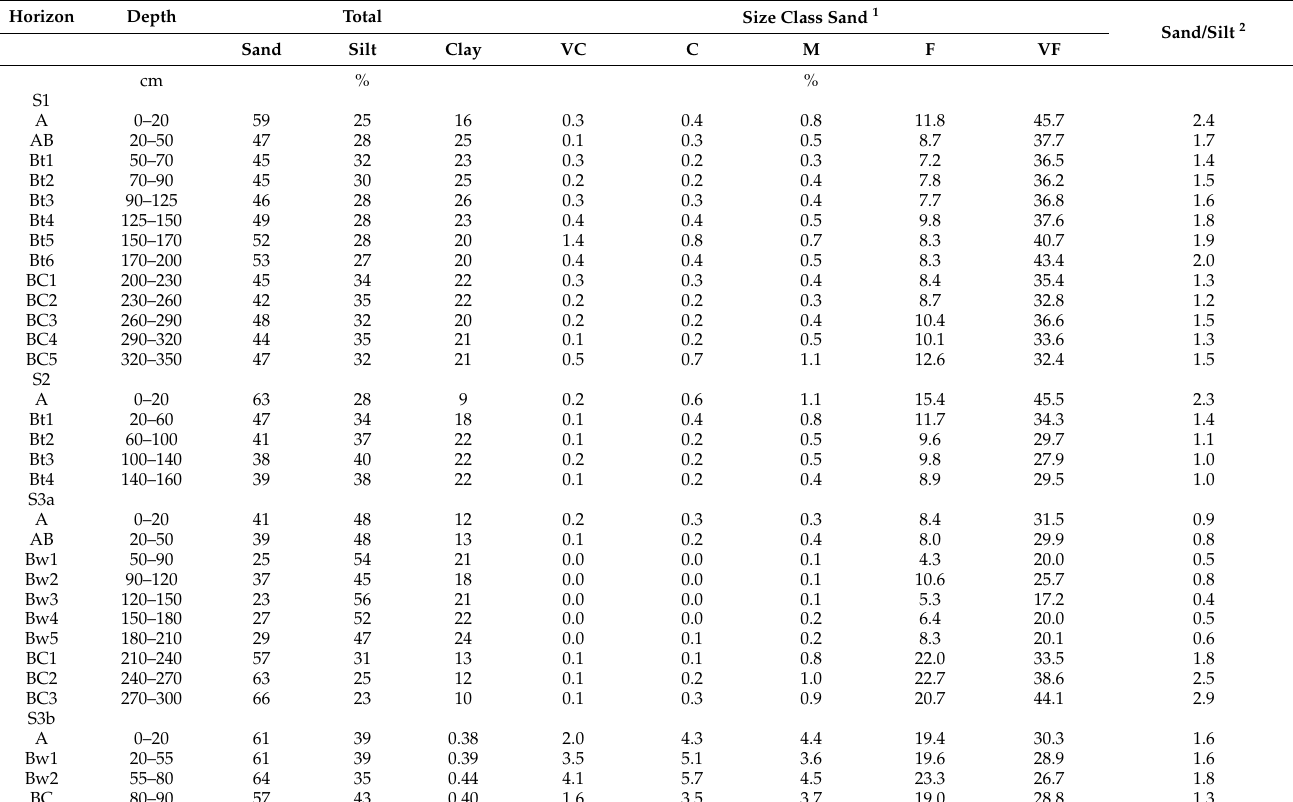
Table 4. Particle size distributions of the